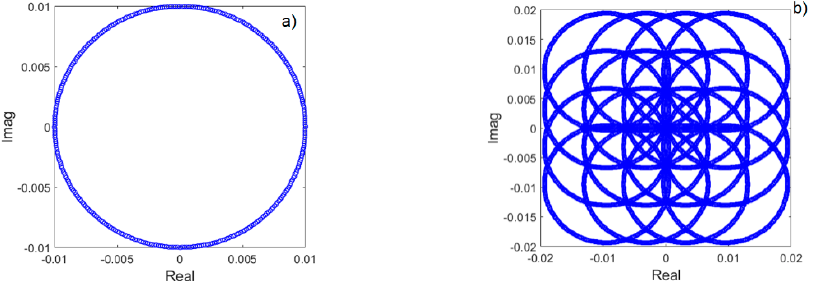
Figure 9. Constellation of the transmitted 8FSK covert signal after perfect ( a ) and imperfect ( b ) SIC operation ( 𝑒 (cid:3028)(cid:3029)(cid:3046) = 2%). Variance of the cover 𝜎 (cid:2869)(cid:2870) =1 and variance of covert 𝜎 (cid:2870)(cid:2870) = 0.01𝜎 (cid:2869)(cid:2870) .